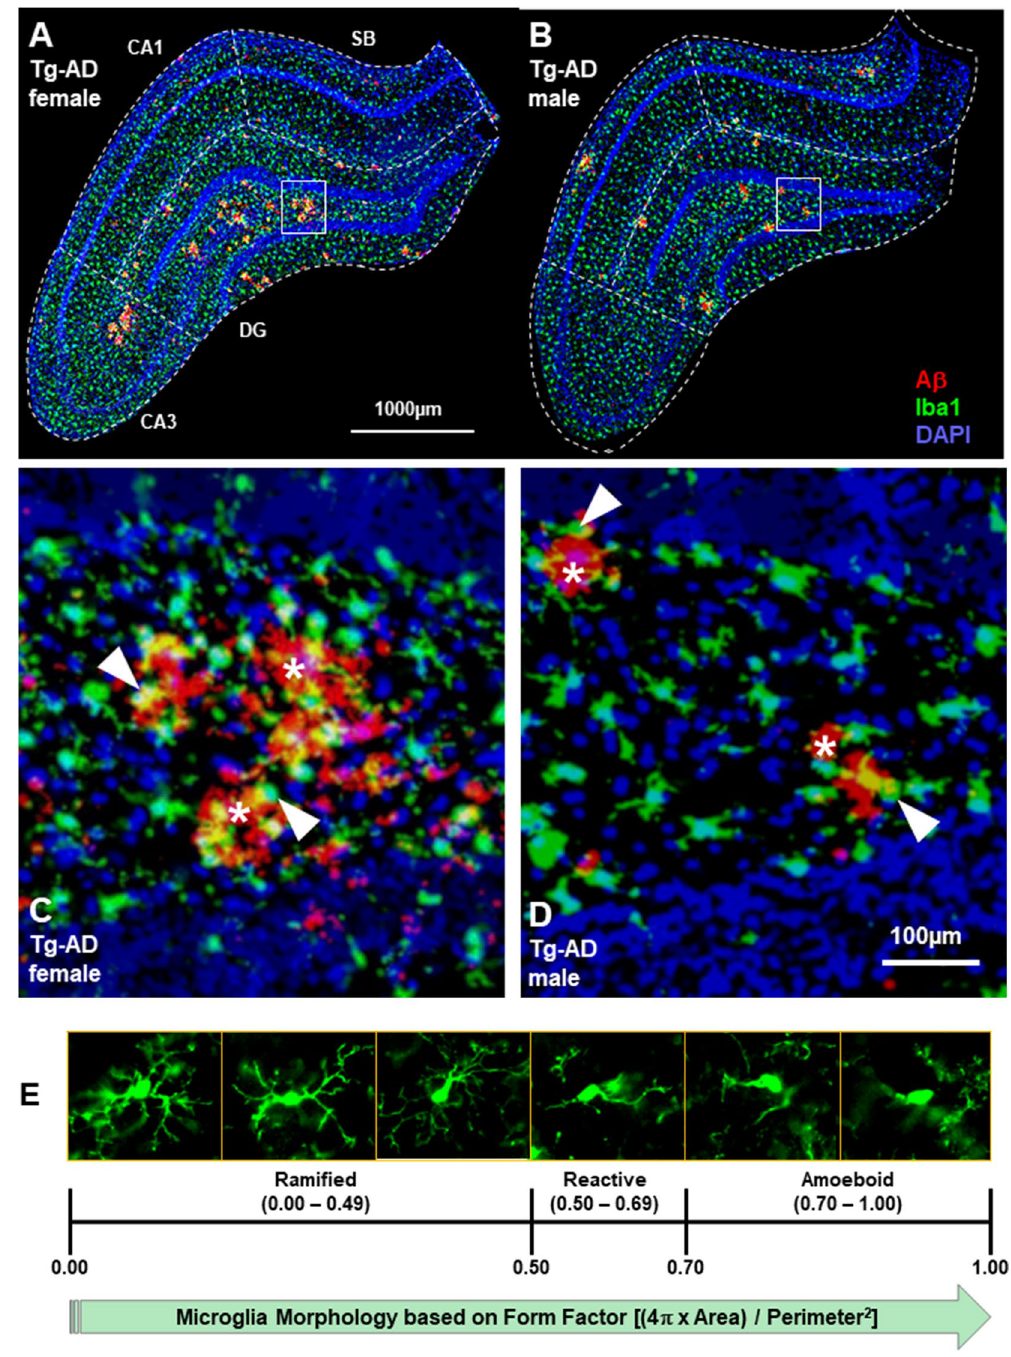
Figure 3. WT female rats have the lowest levels of microglia in the hippocampus compared with the three other groups, Tg-AD females as well as Tg-AD and WT males. IHC analysis for Aβ (red), microglia (green), and nuclei (DAPI, blue) of the right dorsal hippocampus of Tg-AD females ( A ) and Tg-AD males ( B ), 10× magnification, 1000 µm scale bar. Hippocampal region perimeters are depicted in each image by white dashed lines. Bottom panels ( C and D ) represent the magnification of the respective small white boxes depicted in ( A ) and ( B ), 100 μm scale bar. White asterisks show the Aβ plaques (red), surrounded by some microglia [white arrows show co-localization (yellow) of microglia and Aβ]. ( E ), The three microglia phenotypes (ramified, reactive and amoeboid, all Iba1+) are based on circularity (form factor) as explained under material and methods. WT females have significantly fewer microglia (counts/nm 2 ) in the whole hippocampus (right dorsal) than the other three groups of rats ( F ). The number of ramified microglia was not significantly different in the four groups of rats ( G ). The number of reactive ( H ) microglia was significant lower in WT females and males compared to Tg-AD females and males. The number of amoeboid ( I ) microglia for WT females was significantly lower compared to Tg-AD females and males. Ordinary two-way ANOVA with Tukey’s post-hoc tests were used in ( F ) through ( I ). *P < 0.05, **P < 0.01, ***P < 0.001. Females WT (n = 4), Tg-AD (n = 6); males WT (n = 5), Tg-AD (n = 10). CA Cornu Ammonis, DG Dentate Gyrus, SB